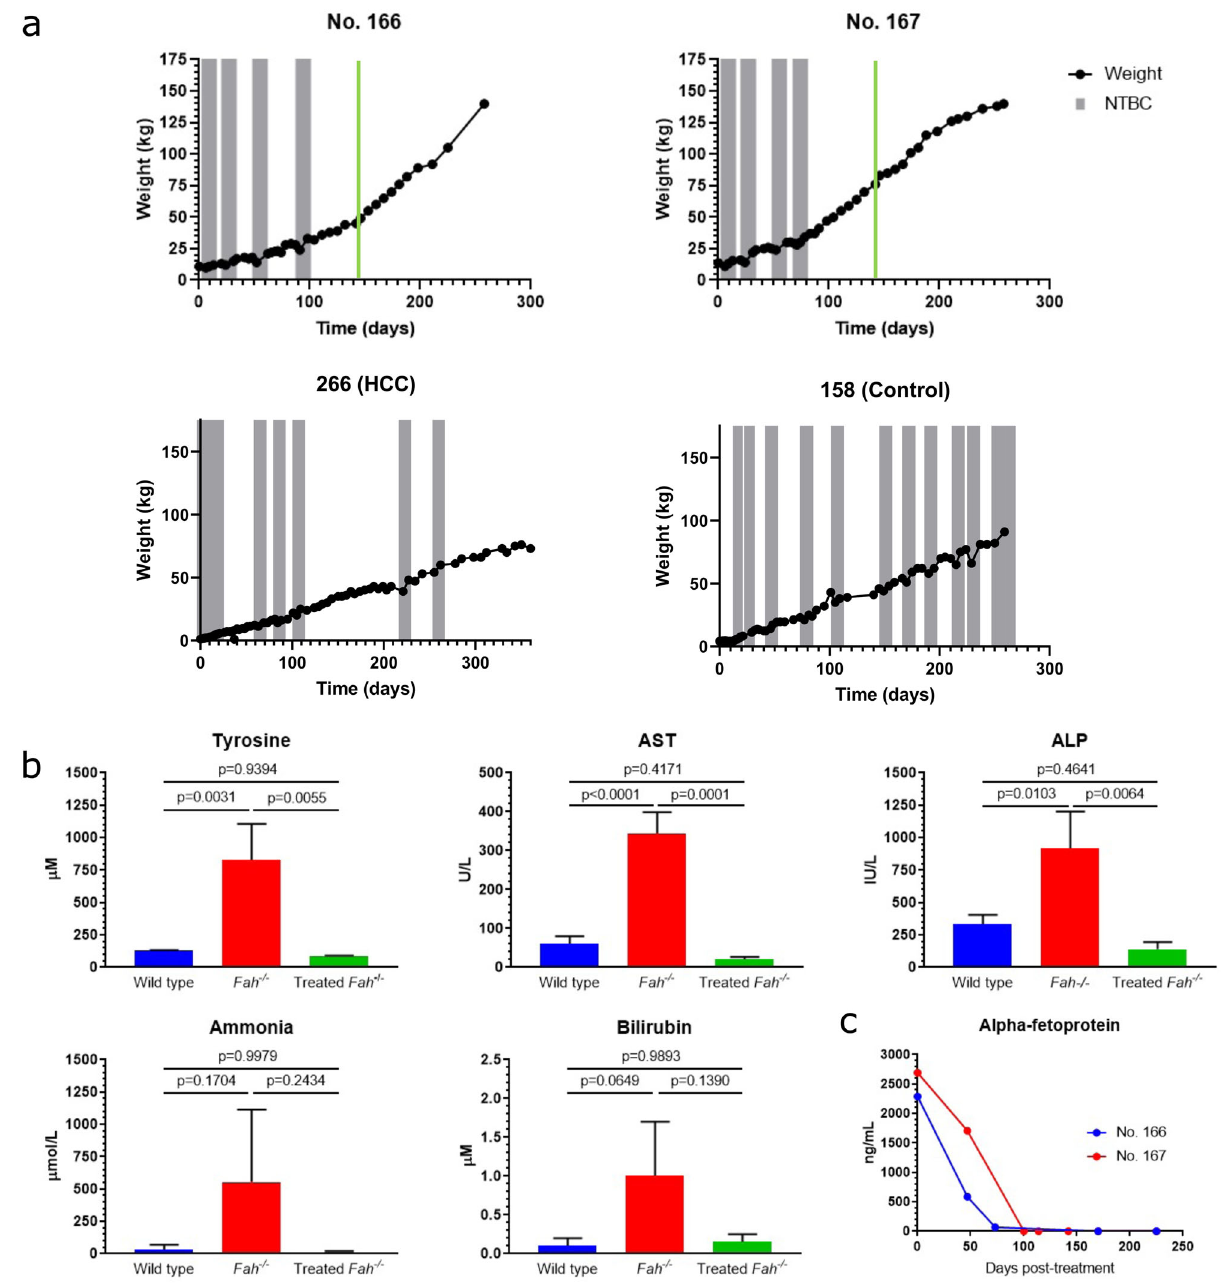
Fig. 2 | NTBC-independent weight gain and correction of biochemical para- meters afterinvivoLV-FAH delivery. a Timeline of NTBCcycling and withdrawal for No. 166 and No. 167 ( fi rst row) demonstrated NTBC-independent growth at 98 and78dayspost-treatment.Eachgraybarrepresents1weekspentonNTBC.Green line represents when blood was drawn for the biochemical data in ( b ). Timeline of NTBC undertreatment for No. 266, which did not receive LV-FAH and developed HCC,andforNo.158,whichdidnotreceiveLV-FAHbutreceivedappropriateNTBC cycling. b Normalization of tyrosine, aspartate aminotransferase (AST), alkaline phosphatase (ALP), ammonia, and total bilirubin levels at 142days post-treatment.